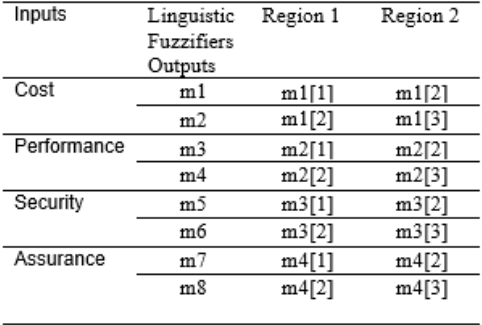
Table 7. Fuzzifier output and Linguistic values